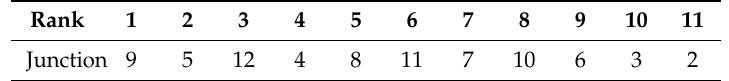
Table 9. Results of pressure contribution analysis using the results of unsteady analysis.